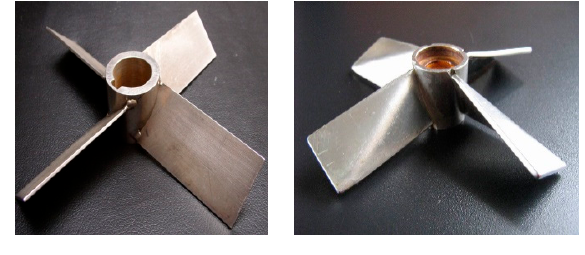
Figure 2. Tested agitators. Processes 2020 , 8 , x FOR PEER REVIEW